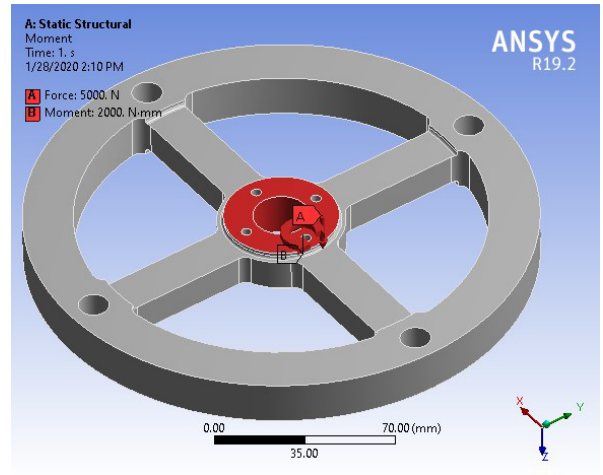
Figure 8. Defining the torsion and axial load in Ansys.